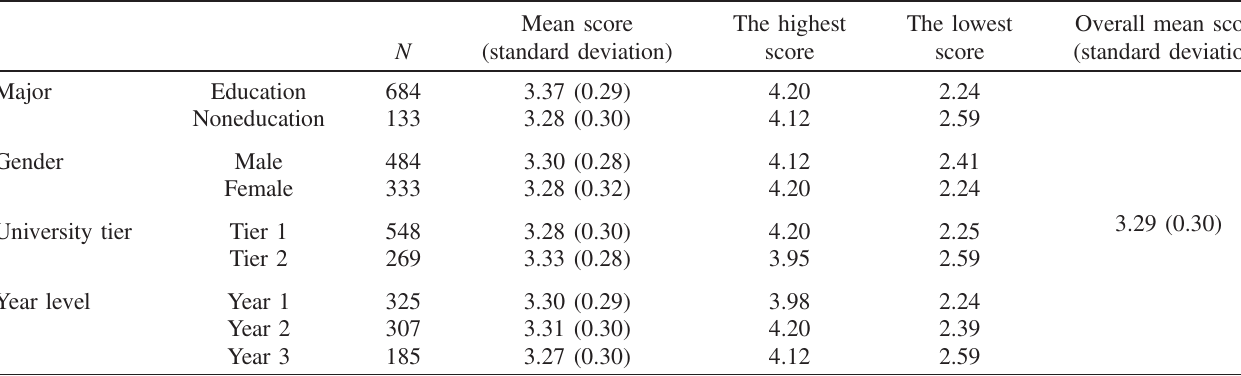
TABLE II. The descriptive statistics of student performances on the